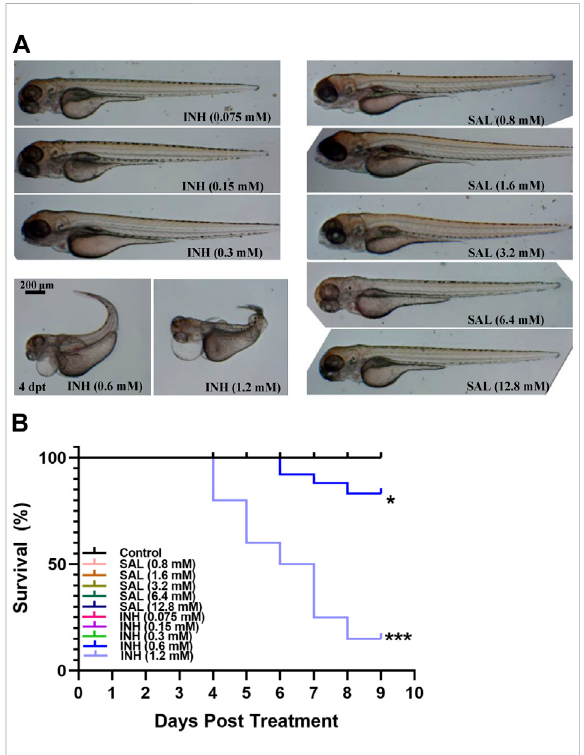
FIGURE 1 SAL has no obvious teratogenic effect on the growth and development of zebra fi sh. (A) Representative photos for zebra fi sh embryos exposed to different concentrations of INH and SAL (4 dpt). (B) Mortality rates of zebra fi sh embryos exposed to different concentrations of INH and SAL from 0 to 8 dpf. A and B; n = 20 per group. This is one representative data from three independent